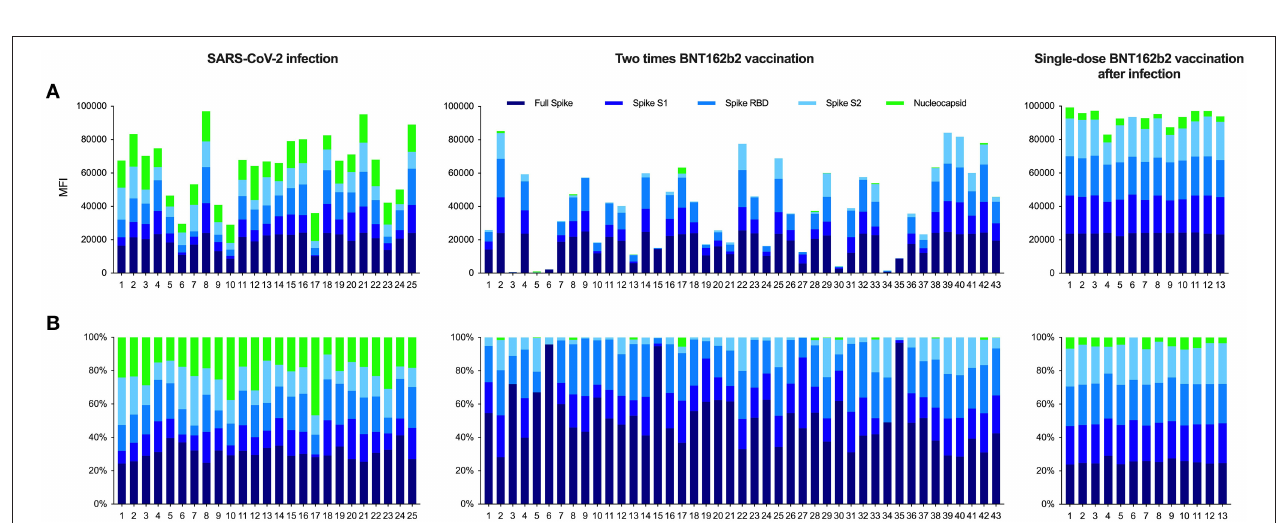
FIGURE 4 | Reactivity patterns for different SARS-CoV-2 target antigens in hemodialysis patients after COVID-19 infection, complete BNT162b2 vaccination, and in previously infected patients receiving a single dose of BNT162b2. Reactivity patterns for five different SARS-CoV-2 target antigens, presented as a histogram (A) and as a histogram plot (B) for each patient. (A) The height of each histogram bar indicates the cumulative mean fluorescence intensity (MFI) value for detected antibodies against the full spike, the S1 spike, the receptor-binding domain of the spike, the S2 spike, and the nucleocapsid protein of SARS-CoV-2. (B) The histogram plot shows the proportional contribution of each target antigen to the total MFI-value and the individual variability of antibody responses in each patient.